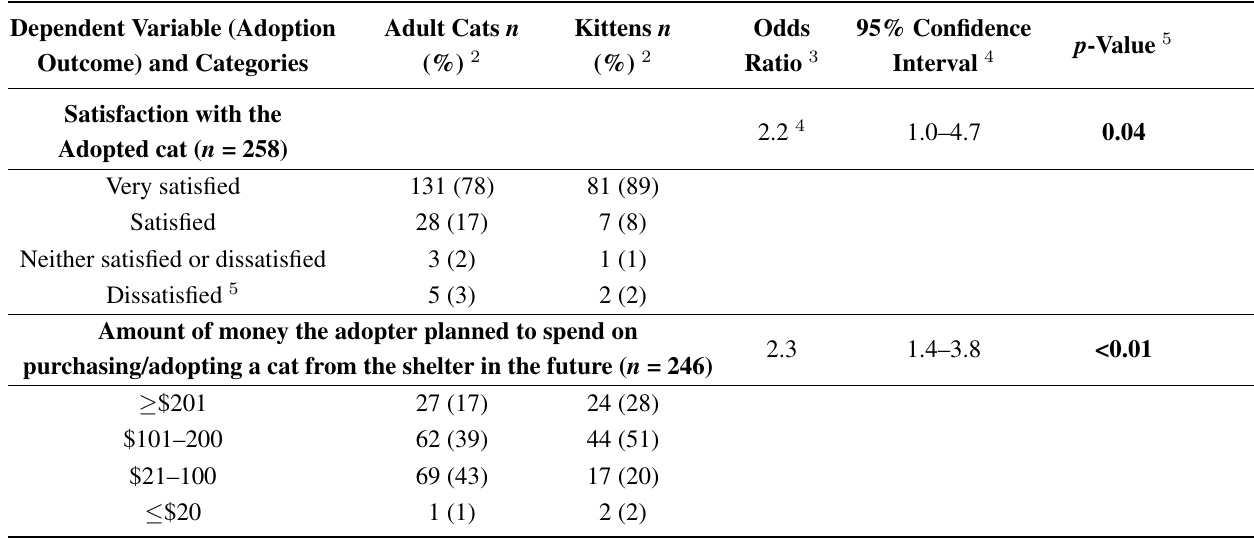
Table 2. Distributions of adoption outcomes by age group of cat adopted (adult cat or kitten) for 271 cats adopted from an animal shelter in Australia in 2013 1